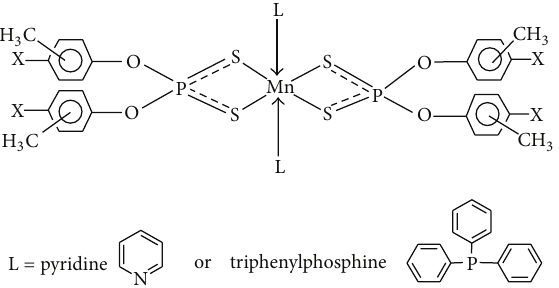
Figure 8: Proposed octahedral structure of complexes of man- ganese(II) with pyridine ( 13 – 16 ) and triphenylphosphine ( 17 – 20 ); X = H, CH 3 , or